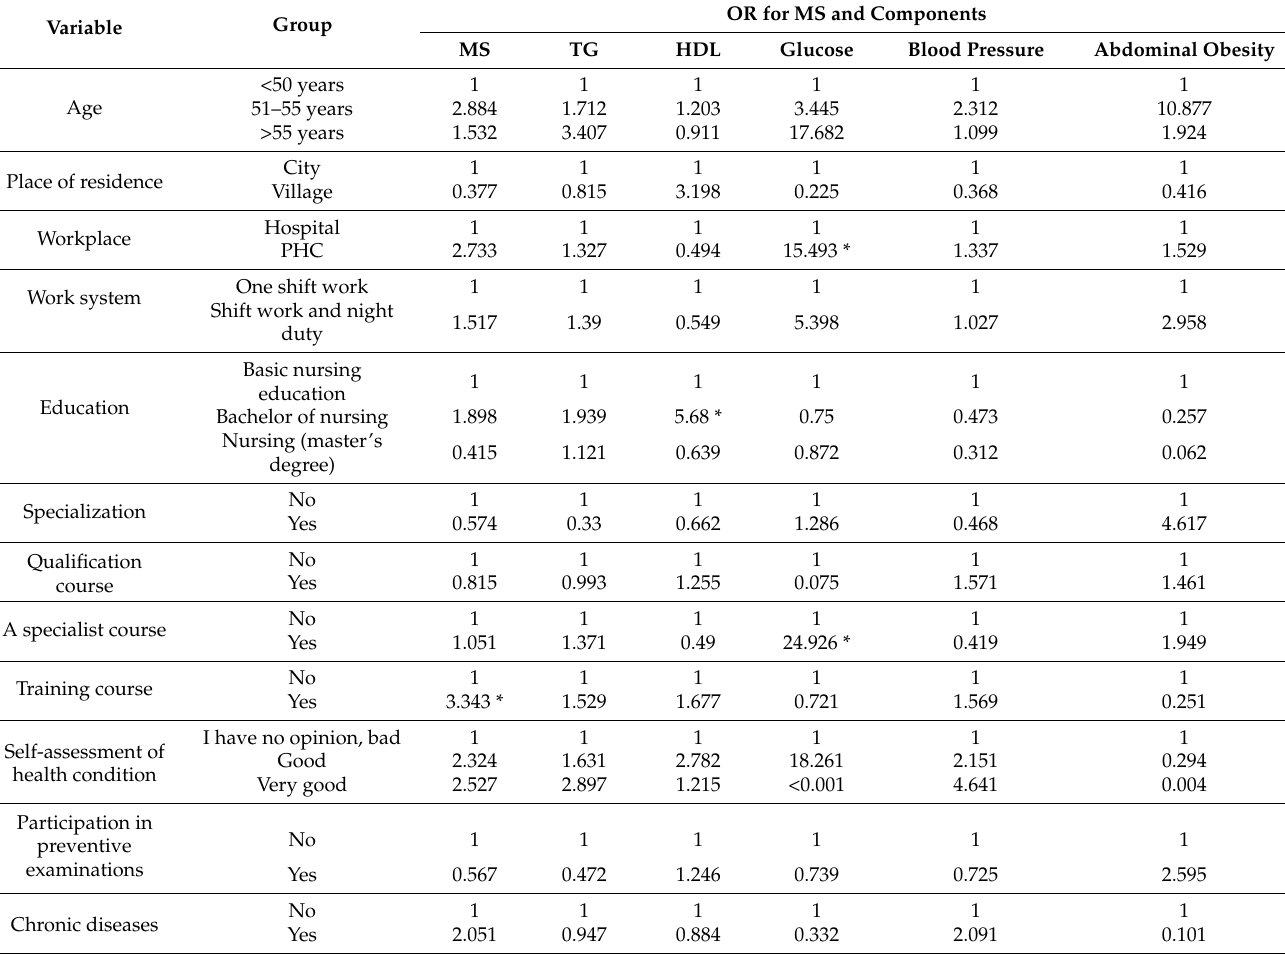
Table 8. Statistical significance of factors in the regression model for metabolic